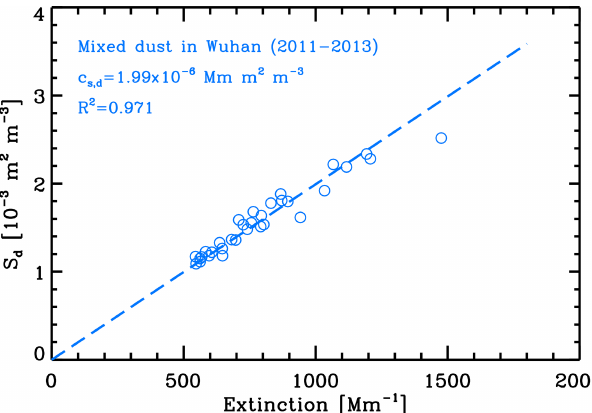
Figure 1. Relationship between extinction coefficient and surface area concentration S d for mixed dust in Wuhan. Correlations are given by sun photometer observations during dust-intrusion days that are verified by ground-based polarization lidar (He et al., 2021b). Each hollow circle denotes a pair of daily averaged values for the dust occurrence period of a dust-intrusion day. The slope of the dashed blue line is defined as the extinction-to-surface area con- version factor (Ansmann et al., 2019b). All the circles are obtained from the dust-intrusion days during 2011–2013.